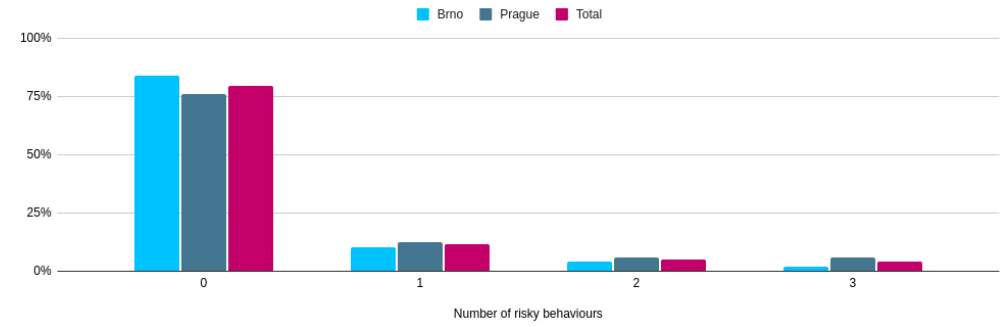
Figure 2. Percentage of pupils based on city categories and the amount of risky tobacco, alcohol and marijuana